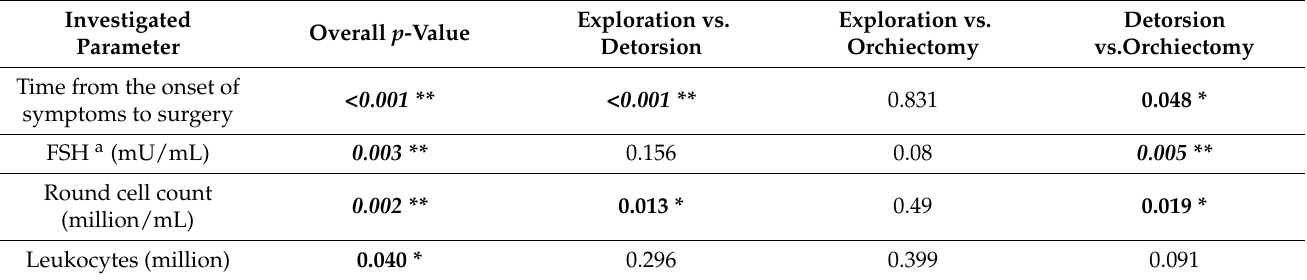
Table 5. Comparison of exploration, detorsion and orchiectomy II by Nemenyi’s multiple comparisons.